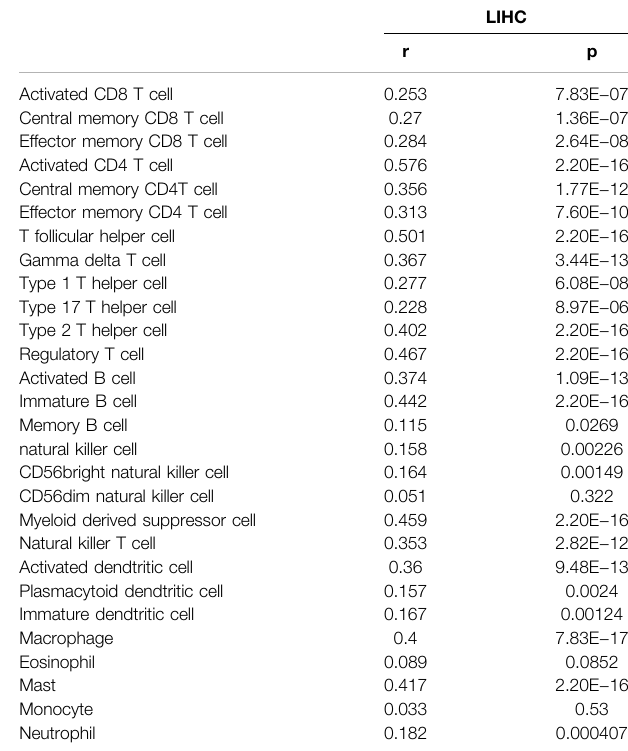
TABLE 5 | The correlation between RAB42 expression and tumor lymphocyte in fi ltration in HCC